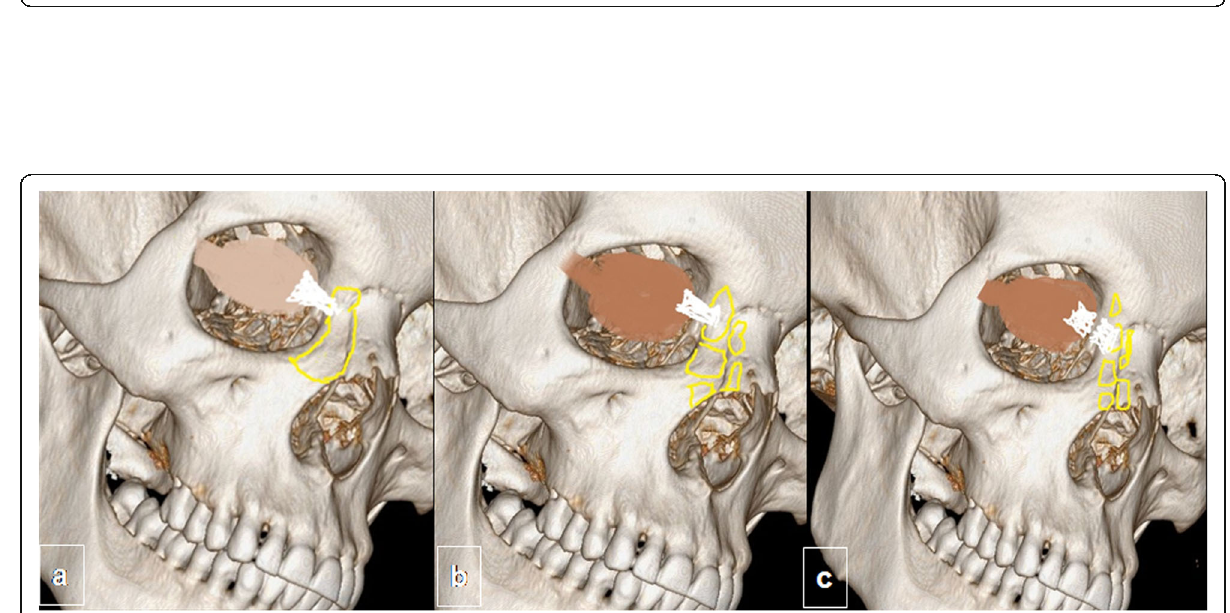
Fig. 8 Two patients with multiple Le Fort fractures. a – c Patient one and ( d , e ) patient two. Patient one: a axial CT image at the level of the inferior maxillary sinus shows fractures in both pterygoid plates (arrowheads). b Axial image at the level of the inferior margin of the orbits shows zygomatic fractures on the right side, illustrating the definition of a Le Fort III fracture (thick arrow). c Coronal image shows involvement of the inferior orbital rim, illustrating the definition of a Le Fort type II fracture (thin arrow). Patient 2: d Axial CT image at an inferior level of the maxillary sinuses demonstrates bilateral fractures through the pterygoid plates (arrowheads) and maxillary sinus walls (arrows), findings indicative of Le Fort type I fractures. e Coronal CT image of the same patient shows a fracture of the inferior aspect of the maxillary sinus walls (thin arrows), a type I Le Fort fracture, and a fracture of the inferomedial orbital walls, a Le Fort type II fracture (thick arrows)